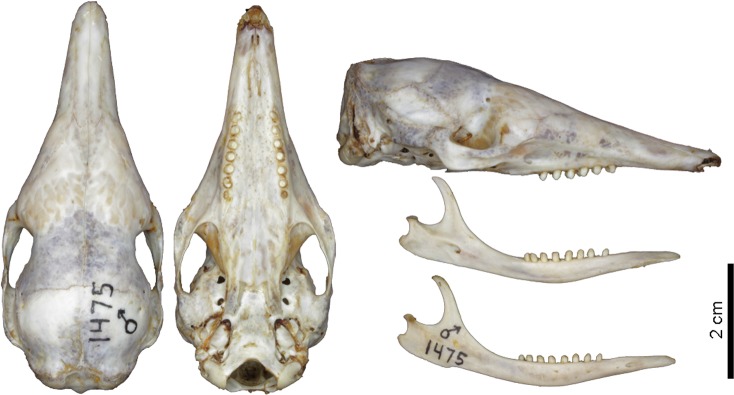
Skull and mandible of Dasypus septemcinctus septemcinctus from Brasilia, Brazil (UNB 1475).